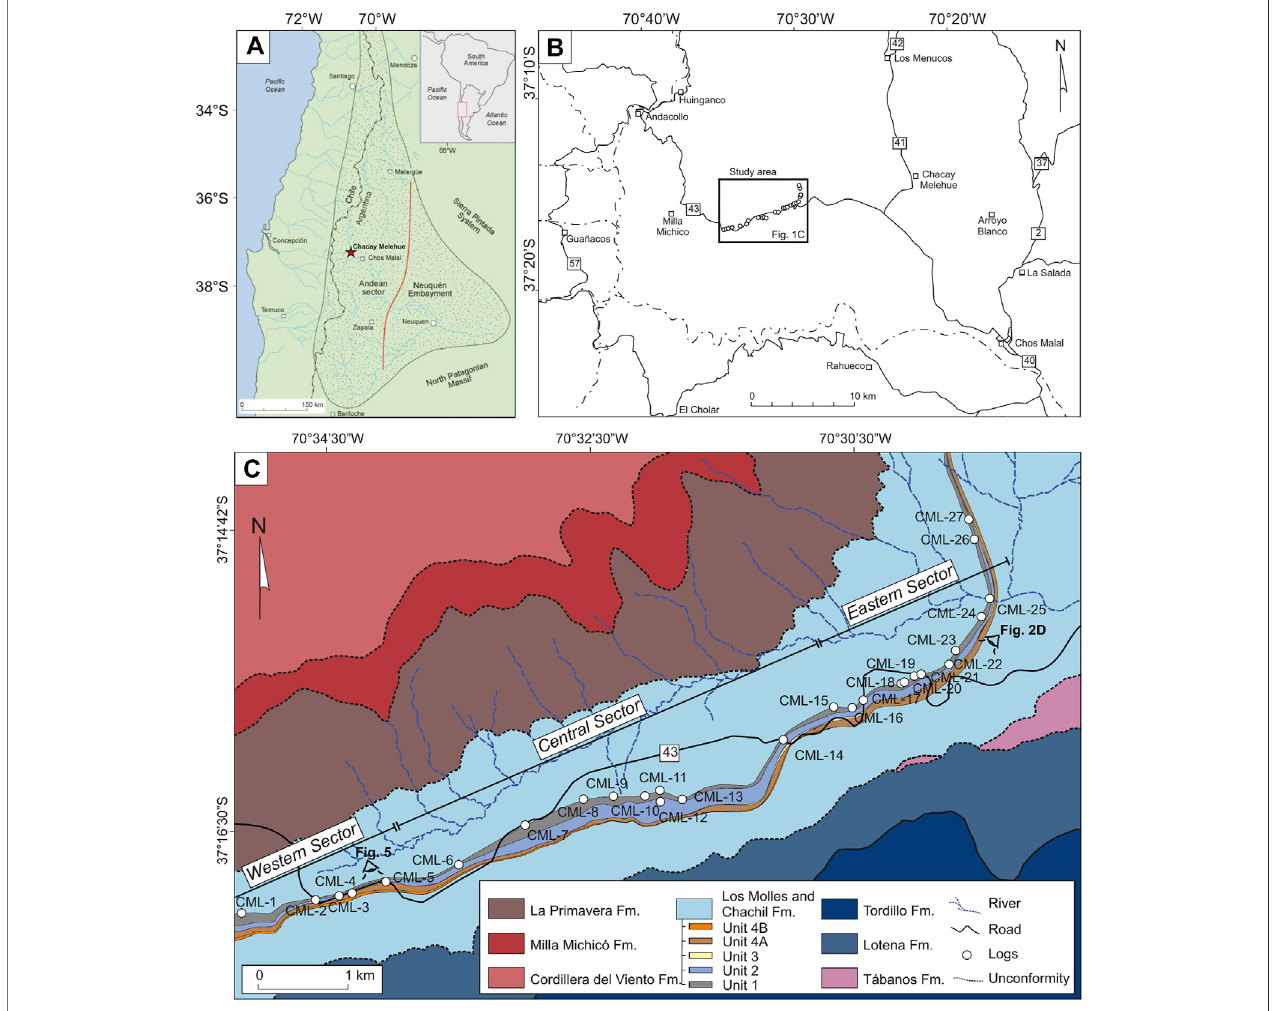
FIGURE1|(A) LocationmapoftheNeuquénBasinandthestudyareaChacayMelehue(redstar). (B) Locallocationmapofthestudyarea. (C) MapoftheChacay Melehue area with the formations [modi fi ed from Llambías et al. (2007)] and the locations of the logs. See the studied units and their distribution.